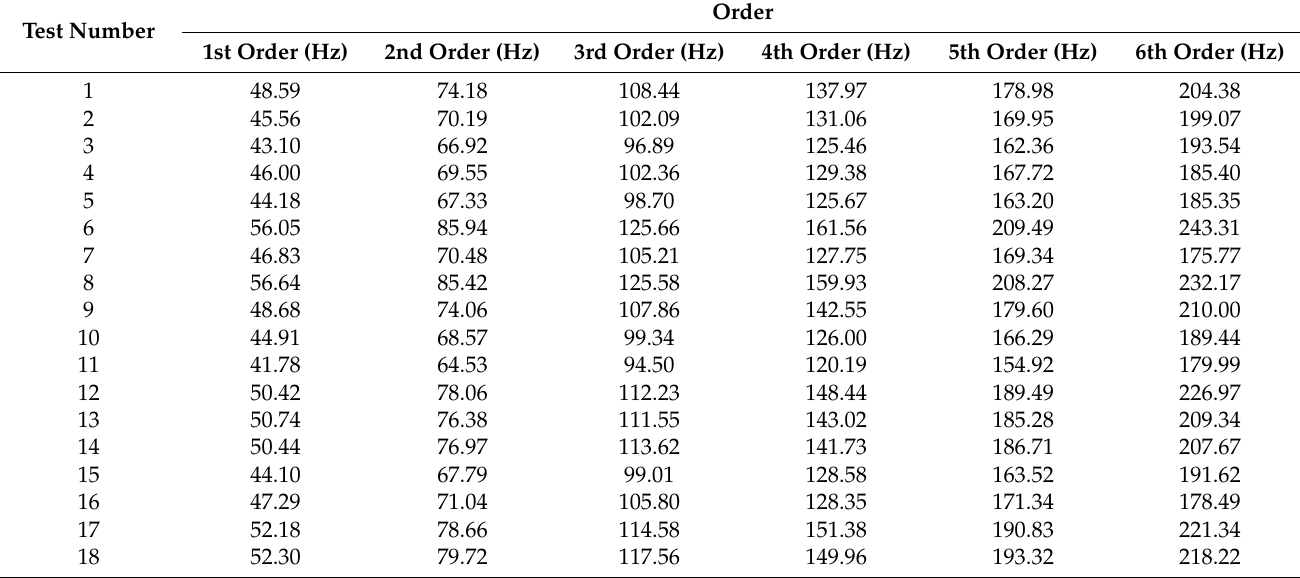
Table 5. The first six natural frequencies after finite element simulation